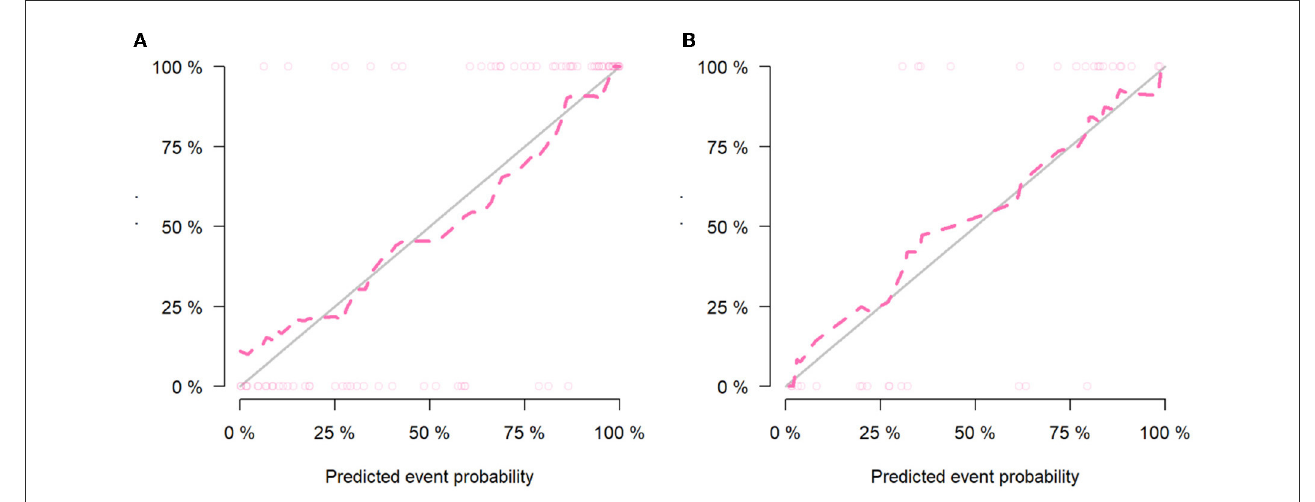
FIGURE5 Calibration curves of the clinical-radiomics model in the training group (A) and validation group (B) .